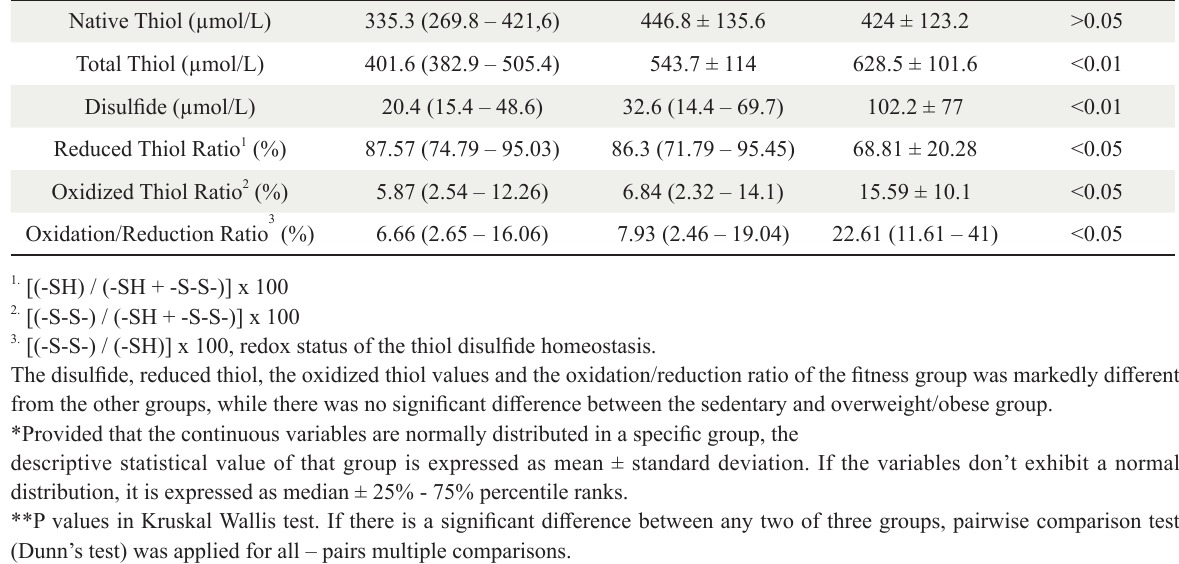
The mean and median values of total thiol, native thiol, disulfide and reduced and oxidized thiol ratio for each group. Overweight/Obese Biochemical Parameters of Sedentary Group* thiol-disulfide homeostasis